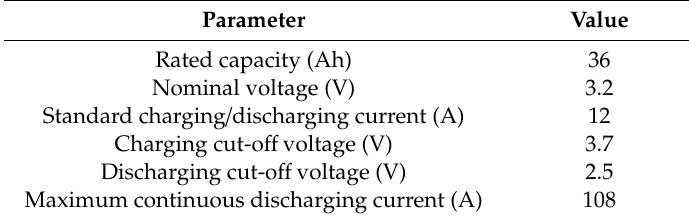
Figure 4. Experimental platform. Table 1. The battery